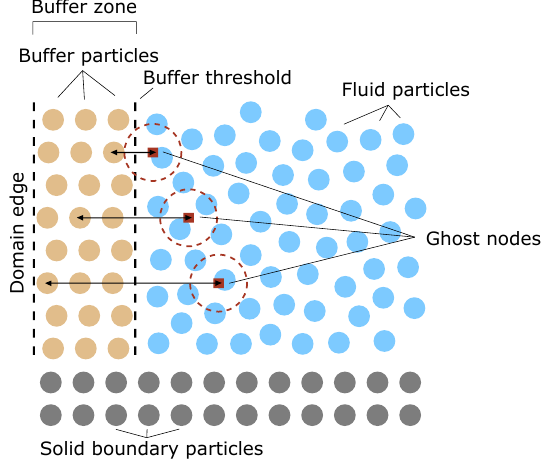
Figure 1. Sketch of the implemented open boundary model, adapted from Tafuni et al.